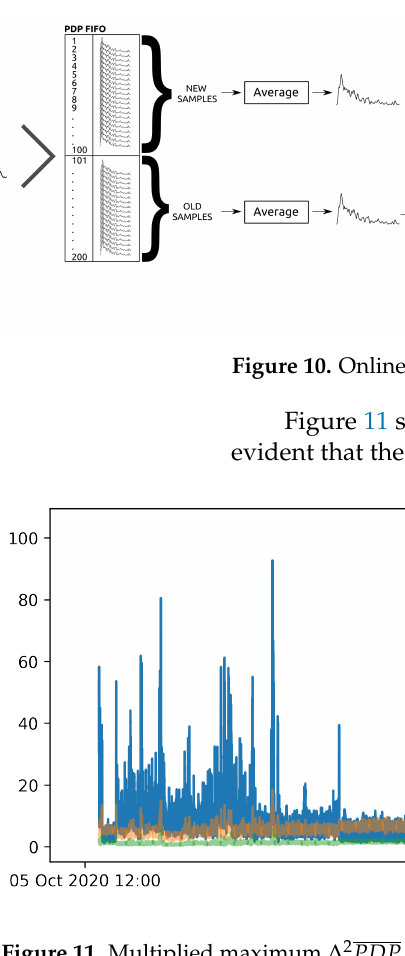
Figure 11. Multiplied maximum ∆ 2 PDP and multiplied standard deviation of maximum ∆ 2 PDP against ∆ PDP